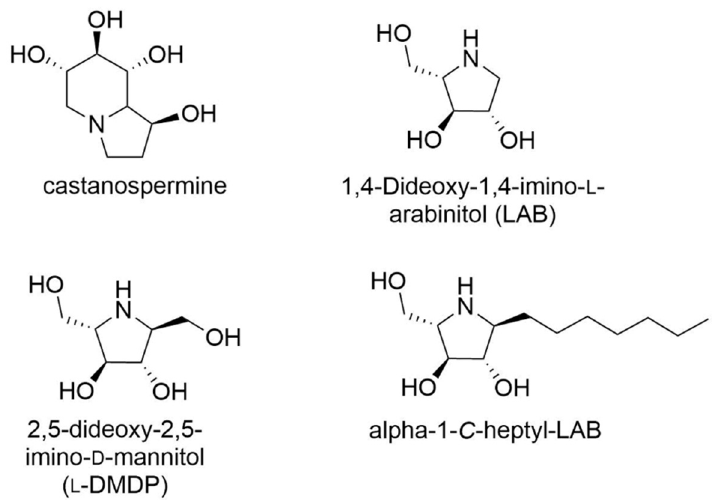
Figure 2. PC with a pyrrolizidinic or pyrrolidinic structures.